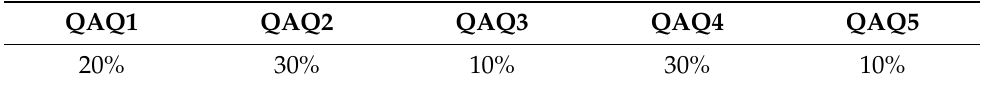
Table 4. Weightings of QAQs.